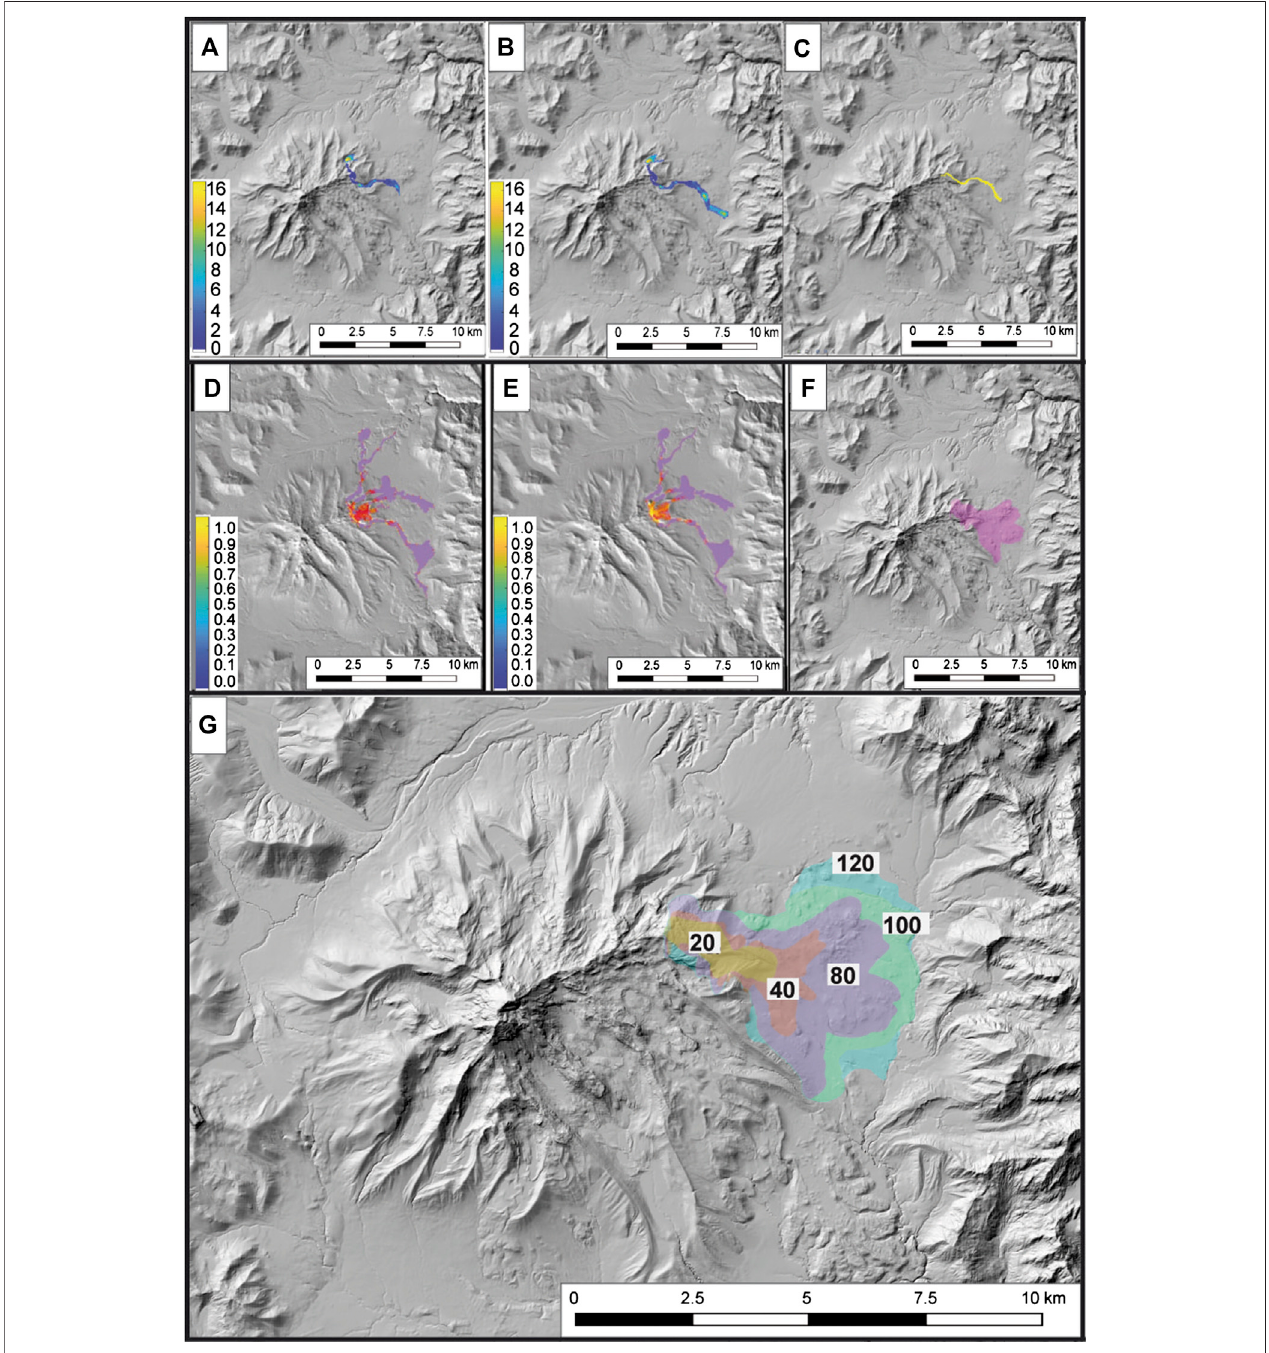
FIGURE 13 | Upper Panel (A – C) : Numerical results from modeling 10 million cubic meters for emplacement of a gravitational fl ow breccia. (A) Scenario I in VolcFlow, (B) Scenario II in VolcFlow; color bar represents thickness of deposit in meters. (C) LaharZ/PFz results ( LaharZ/PFz does not provide thickness quantitative results).MiddlePanel (D – F) :Numericalresultsfrommodelingavolumeof80millioncubicmetersforemplacementofabreccia. (D) ScenarioIinVolcFlow, (E) ScenarioII in VolcFlow; (F) LaharZ/PFz results ( LaharZ/PFz does not provide thickness quantitative results). Bottom Panel: (G) Nested inundation areas for 20 – 120 Mm 3 volumes, respectively, for emplacement of the breccia, modeled with LaharZ/PFz.